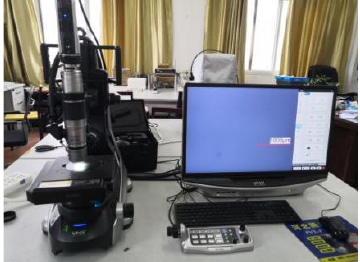
Figure 10. Super-depth-of-field microscope.